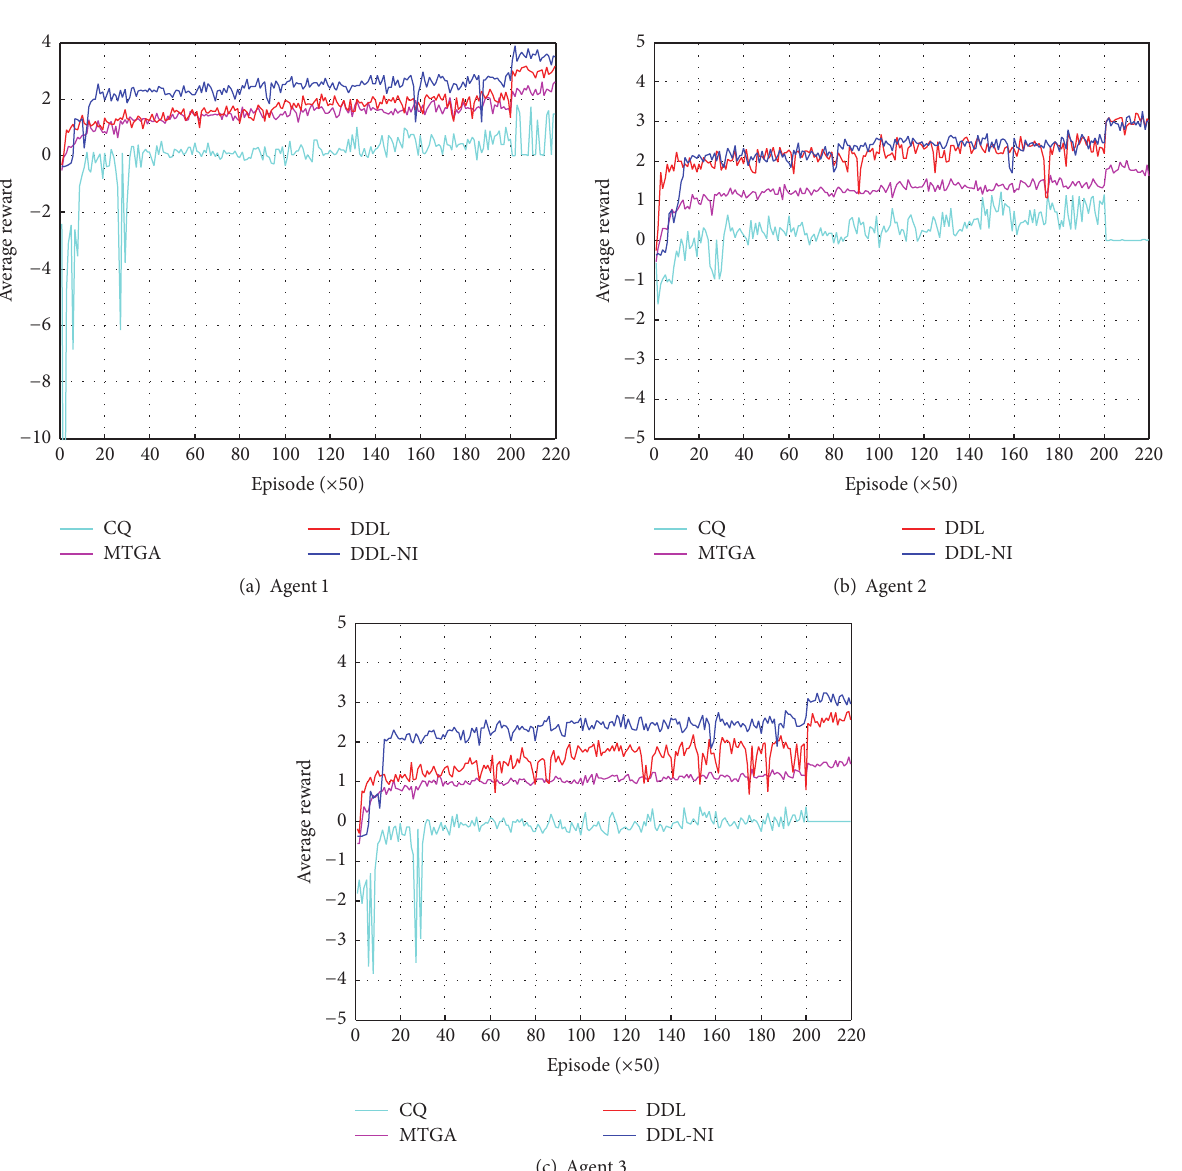
Figure 7: The learning curves of the tested approaches in game